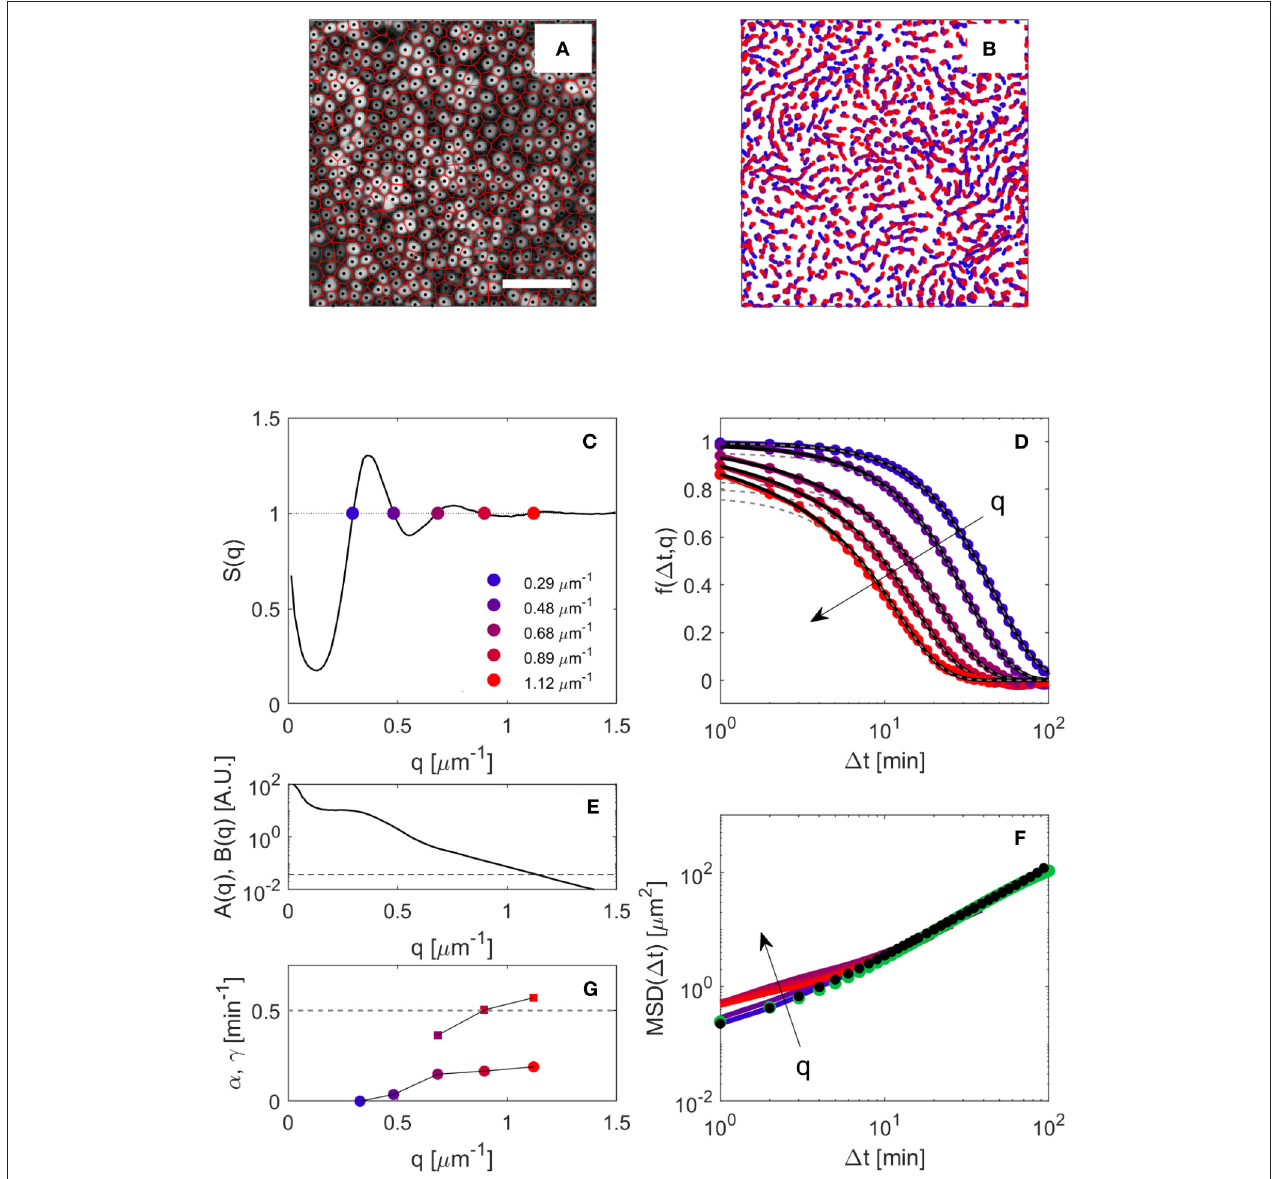
FIGURE 1 | (A) Representative wide-field fluorescence microscopy image of a highly-confluent MDCK monolayer. Bar corresponds to 100 µ m. Black dots indicate the positions of the nuclei, as obtained from PT. The red network is the Voronoi diagram of the nuclei. (B) Trajectories of the nuclei over a time interval of 200 min, about 3 h after the beginning of the experiment. (C) Structure factor S ( q ) of the monolayer about 3 h after the beginning of the experiment, obtained as an average over 6 independent FOVs. Colored points are drawn in correspondence of the five smallest wave-vector q i for which S ( q ) = 1. (D) ISF obtained from DDM analysis for the five wave-vectors outlined in (C) , with the same color code. Continuous black lines are fits to the data with the model given in Equation (11) (see text for details). The slowest decay obtained from the fit is also shown as dashed gray lines. (E) Signal amplitude A ( q ) (continuous line) and noise baseline B ( q ) (dashed line), as obtained from Equations (5, 6). (F) Continuous lines: MSD h| 1 x | 2 i extracted from direct inversion the ISFs shown in (D) using (Equation 10) (color code as in C,D ), black dots, low- q limit of the MSD; green dots, MSD obtained from PT. (G) Relative amplitude α and correlation rate γ of the fast decay obtained by fitting the ISFs shown in (D) with Equation (11). The dashed horizontal line corresponds to γ = 0.5 min − 1